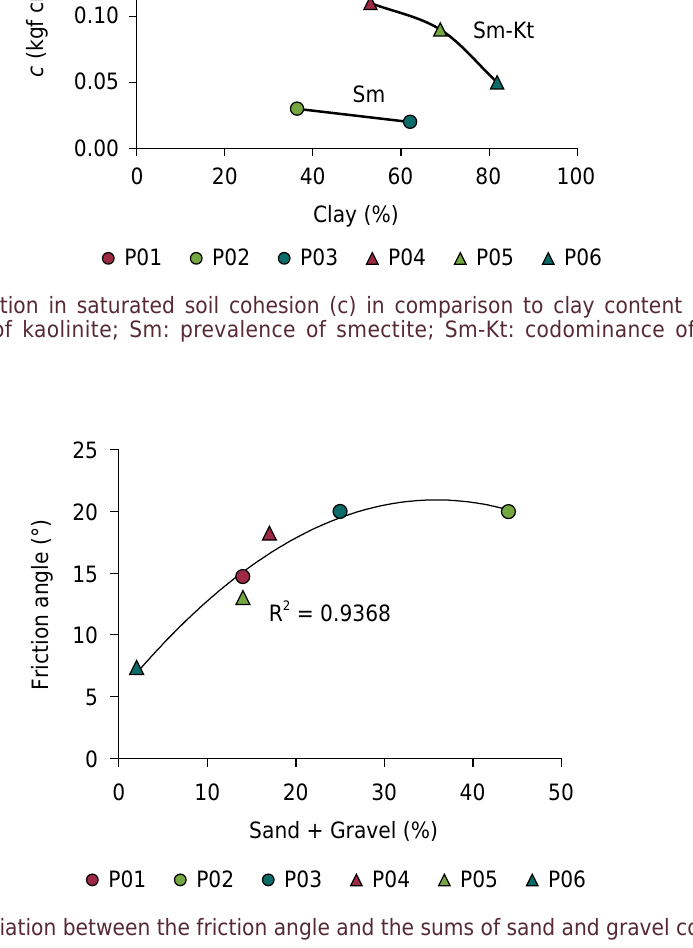
Figure 11. Association between the friction angle and the sums of sand and gravel